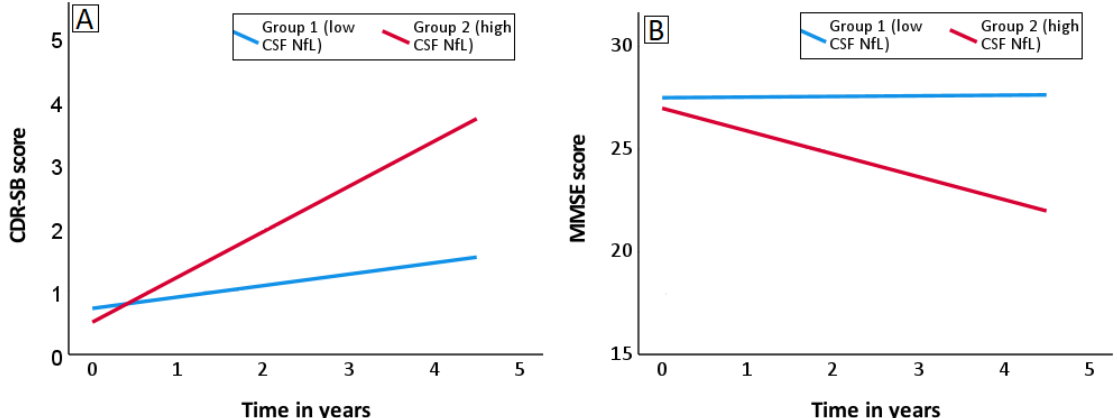
Figure 3. Prediction of cognitive decline in participants with MCI as a function of CSF NfL over 4.5 years. Participants with MCI ( n = 32) were categorized into two groups–high and low CSF NfL — using a cut-off value of 807 pg/mL (50th percentile). Trend lines depicted in the above graphs are regression lines. ( A ) Rate of change in CDR-SB scores in high and low CSF NfL groups. ( B ) Rate of change in MMSE scores in high and low CSF NfL groups. The rate of decline in cognition (rate of increase in CDR-SB and rate of decrease in MMSE) was higher in the group with higher baseline CSF NfL. Abbreviations: CSF: cerebrospinal fluid; CDR-SB: Clinical